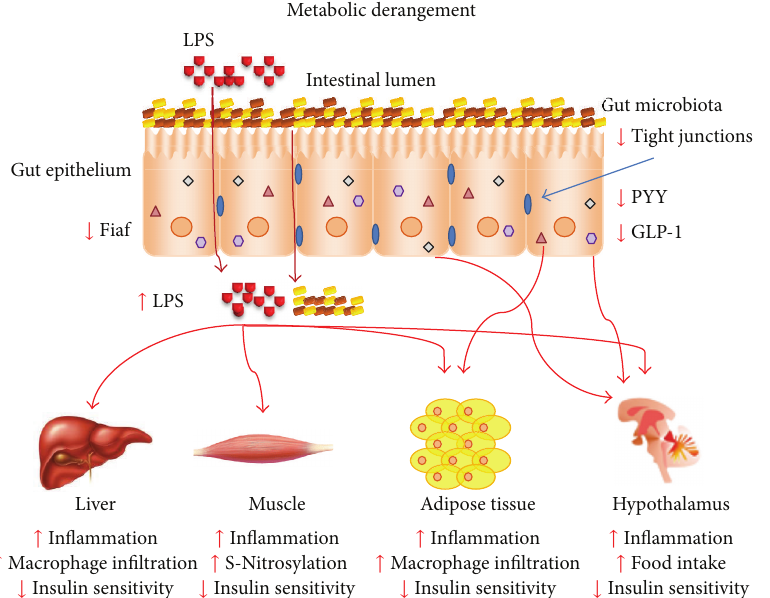
Figure 1: The gut microbiota is modulated by metabolic derangement, such as nutrition overload and obesity, which promote a cluster of metabolic disease-associated processes that culminate in bacterial products and whole bacteria translocation to the circulation through increased intestinal permeability caused by a reduction in tight junction expression. This triggers an immune response, inflammation, and immune cell infiltration of liver and adipose tissue. It induces insulin resistance in various tissues by diverse mechanisms and food intake deregulation in the hypothalamus promoted by the insulin and leptin resistance and also inhibited expression of gut-secreted anorectic hormones, such as GLP-1 and PYY. Additionally, there is a reduction in the intestinal Fiaf expression mediated by bacteria that deregulate the fat storage and lipid metabolism favoring the obese